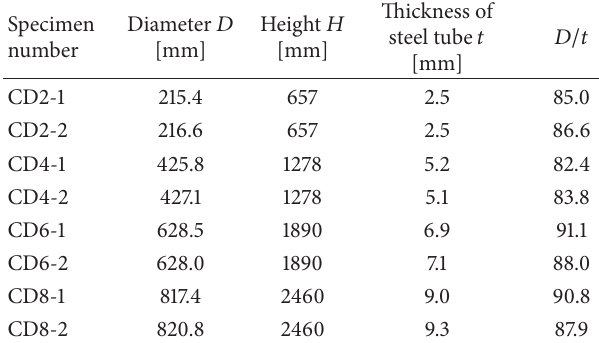
Table 1: Specimen design details.